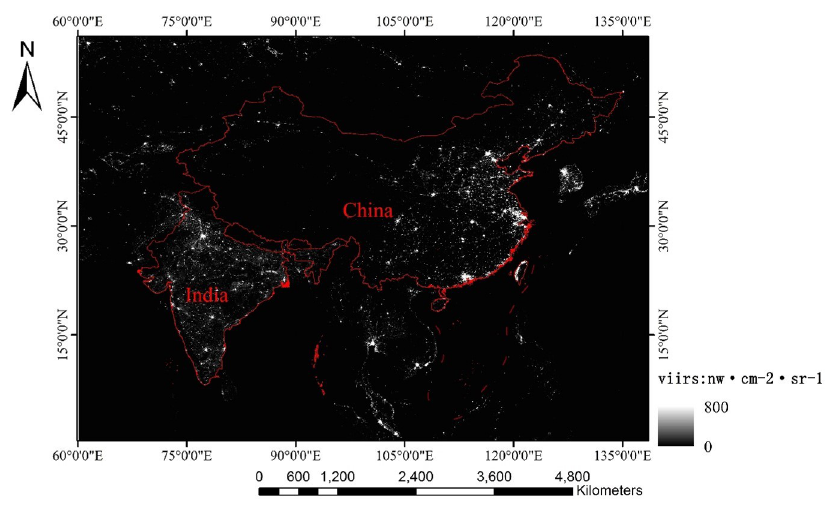
Fig 1. 2015 annual average VIIRS data in China and